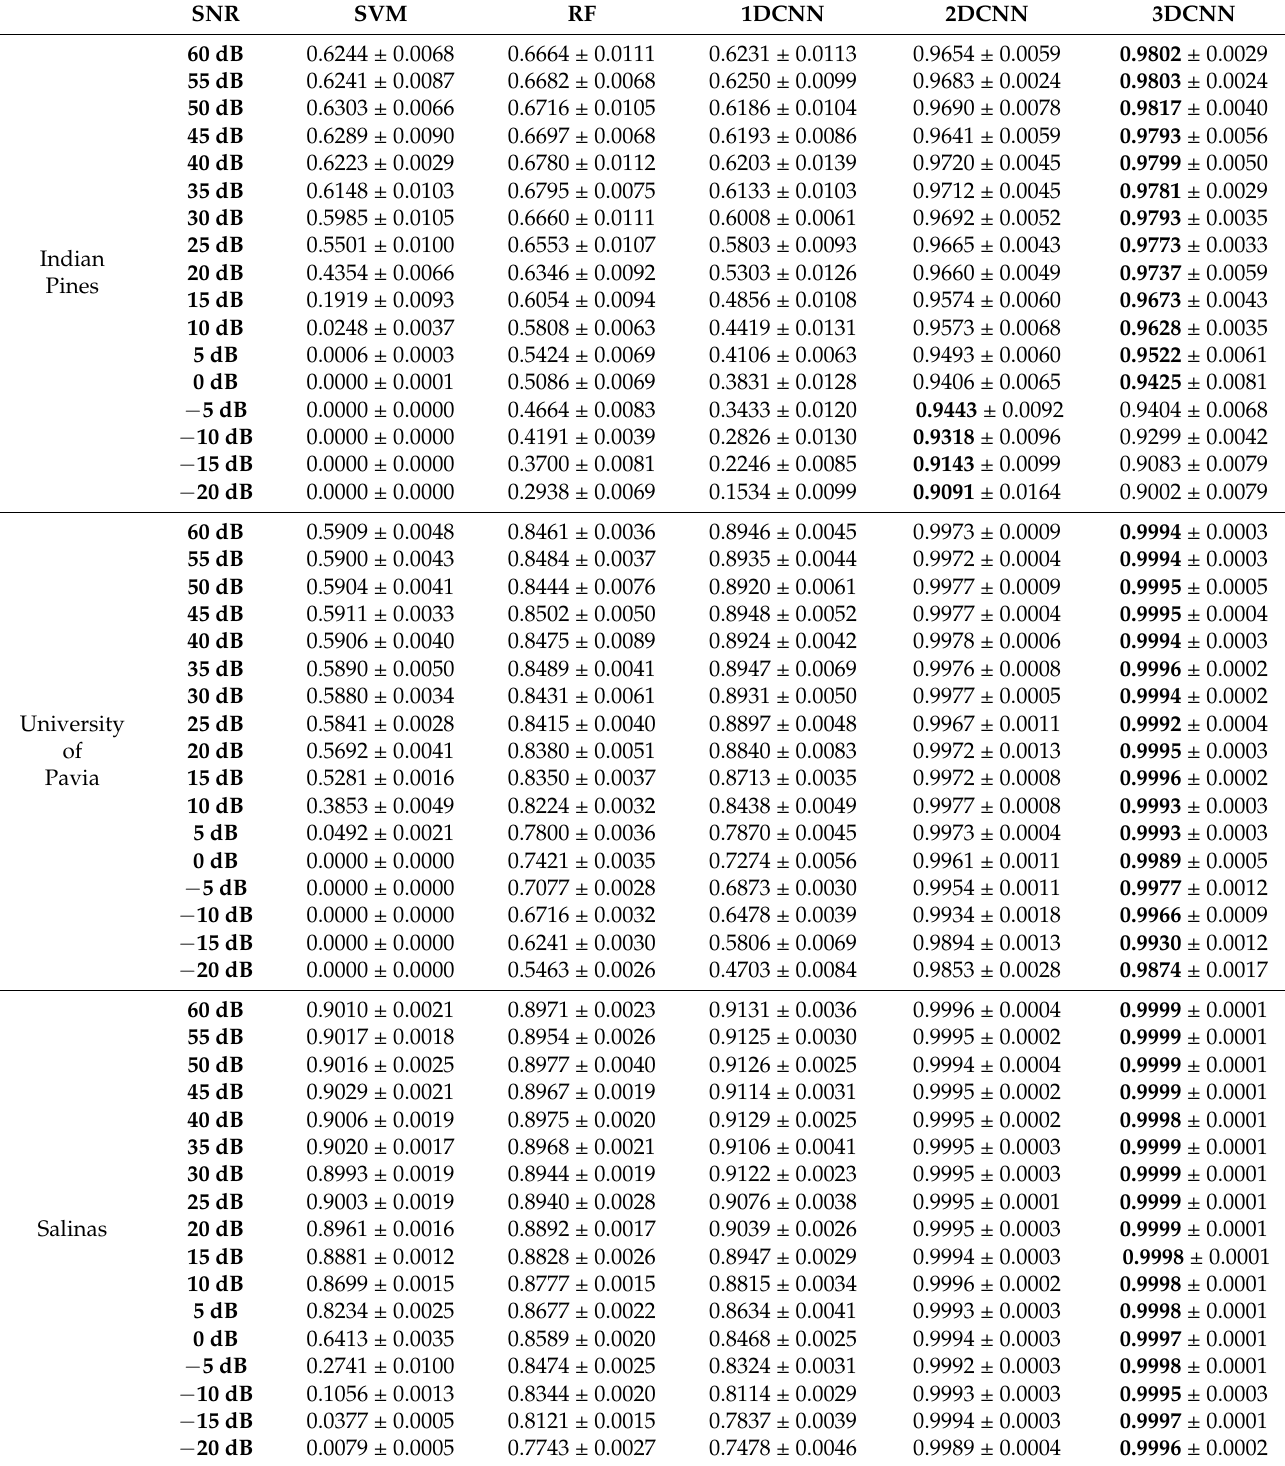
Table A1. Average Cohen’s Kappa coefficient of 10 runs obtained using different classifiers for IP, UP, and SAL compressed with TKD to 40 tensorial bands training with 10% of TS. Standard deviation shows very low variability for high-SNR cases, growing as the noise variance